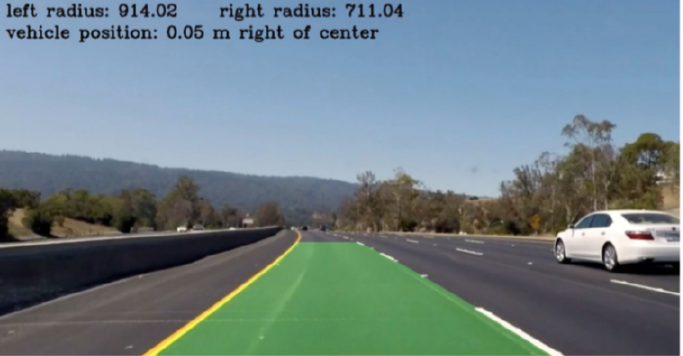
Figure 5. Lane detection for curved